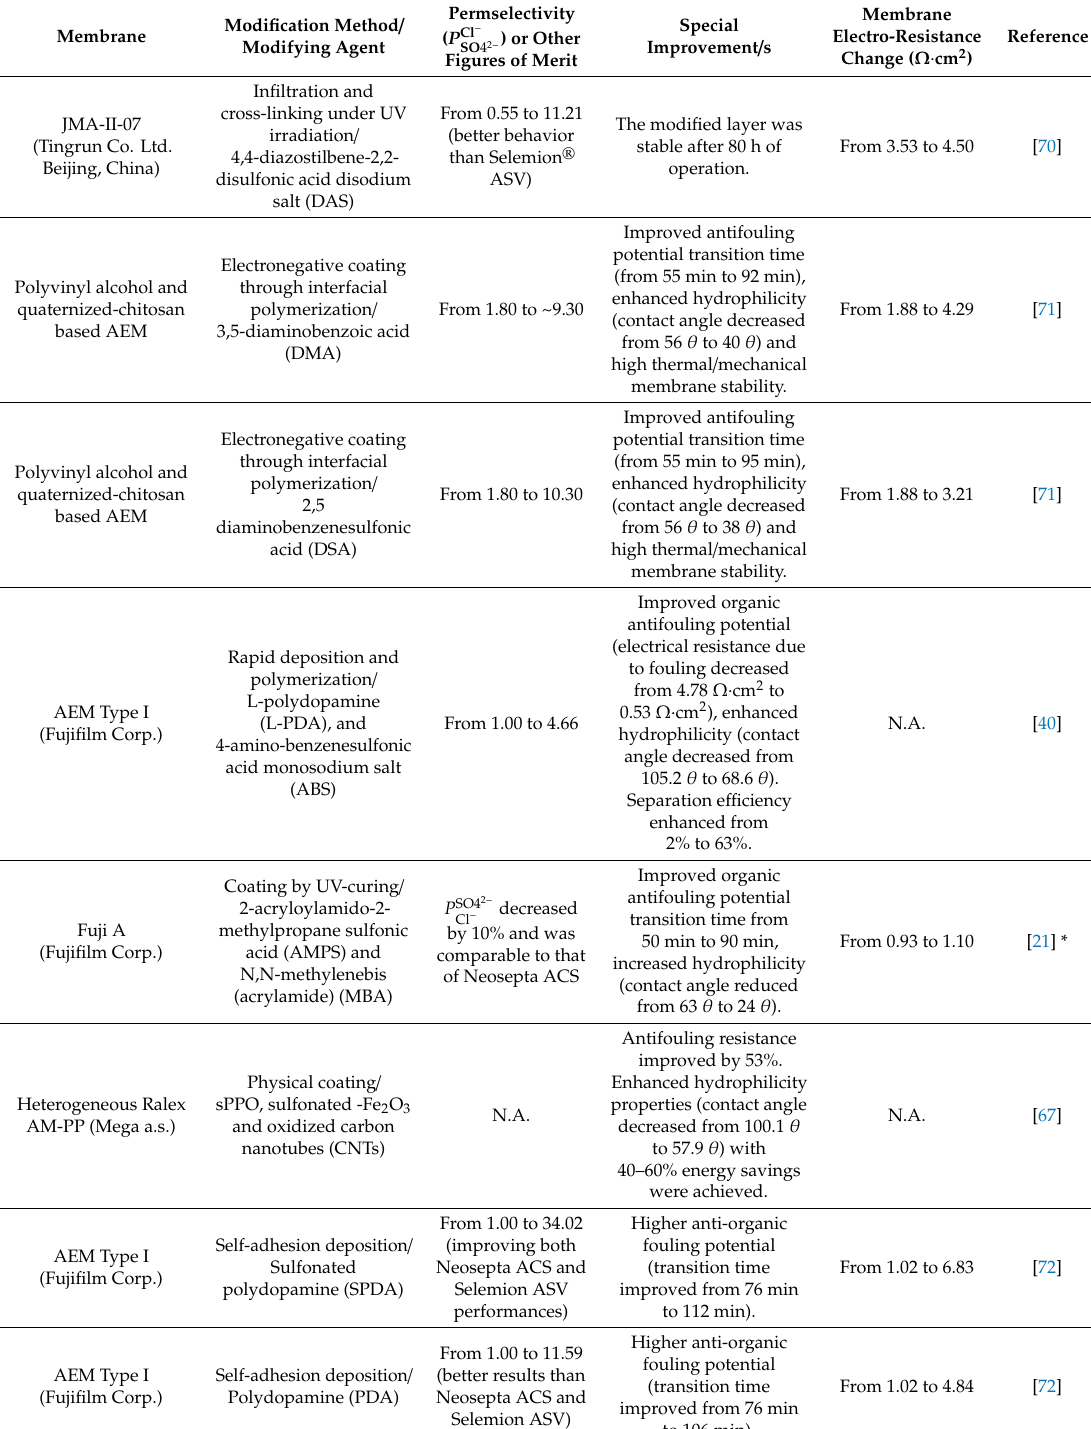
Table 1. Modified AEMs with improved monovalent permselective, hydrophilic, or antifouling properties with promising potential to be used in RED